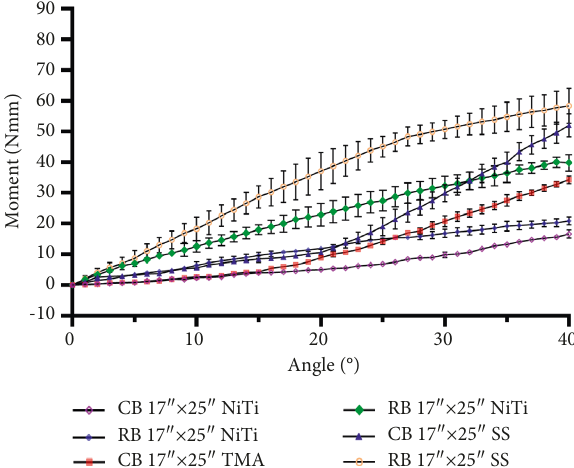
Figure 5: Measured moments acting on the incisor with combi- nations of brackets and 0.017